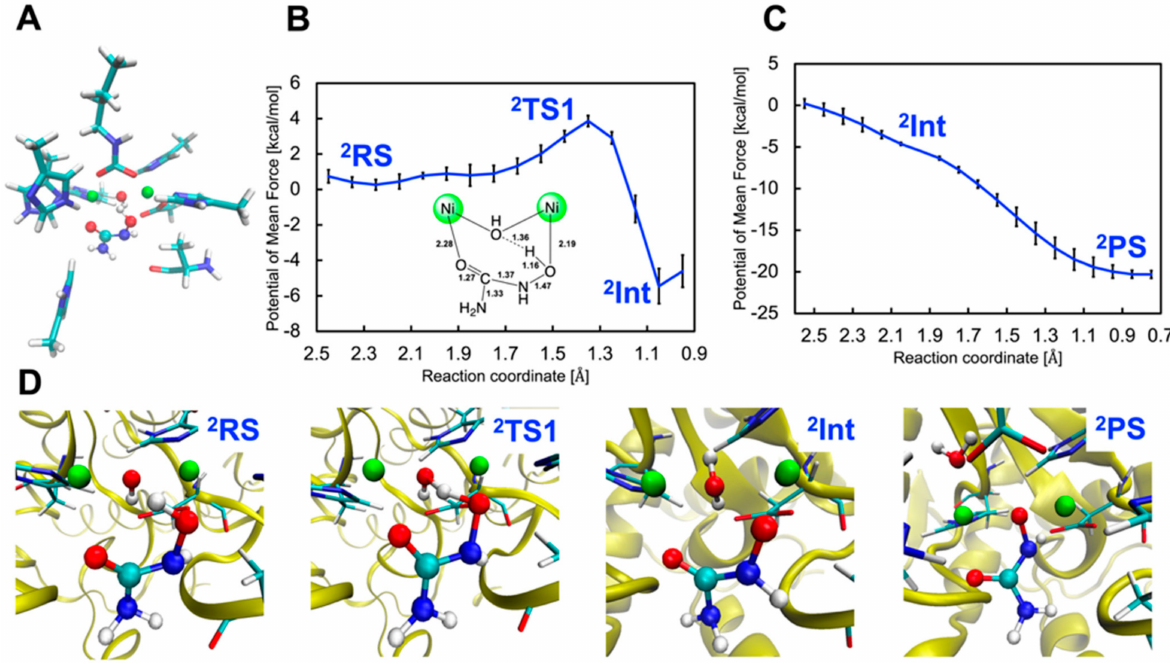
Figure 2. ( A ) QM region of HU( 2 )-bound complex ( 2 RS ) obtained with the QM/MM MD equilibra- tion; ( B ) one-dimensional potentials of mean force (1D-PMFs) for the proton transfer from HU to WB, with an illustration of 2 TS (key distances are provided in Å); ( C ) 1D-PMFs for AHA-inhibited complex formation; and ( D ) representative snapshots of the active sites in 2 RS , 2 TS , 2 Int , and 2 PS . Figure 2B displays the 1D-PMFs along the reaction coordinate set to the H(HU) ••• O(WB) separation in the range from 0.90 to 2.50 Å (denoted as CV d3). We were able to locate